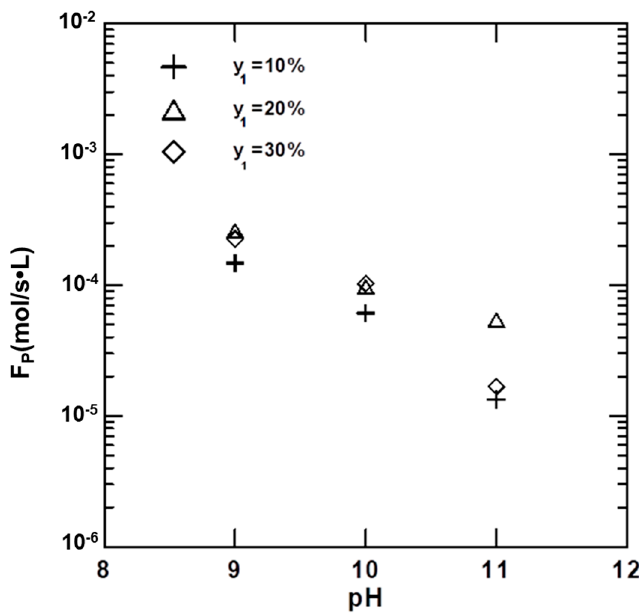
Figure 11. Variation in F p with pH at different y 1 values.